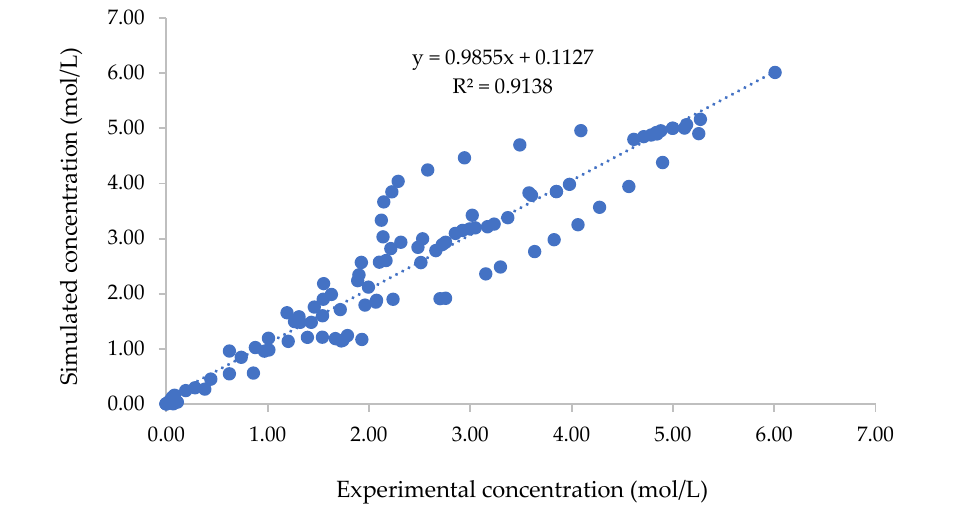
Figure 14. Parity plots for [PA] aq , [PA] org , [PPA] aq , [HP] aq , [EP] org , and [DB] org from the kinetic model of propionic acid perhydrolysis over Amberlite IR ‐ 120 for Runs 1V and 2V. (DB: double bond, EP: epoxide, PPA: perpropionic acid, PA: propionic acid, and HP: hydrogen peroxide).